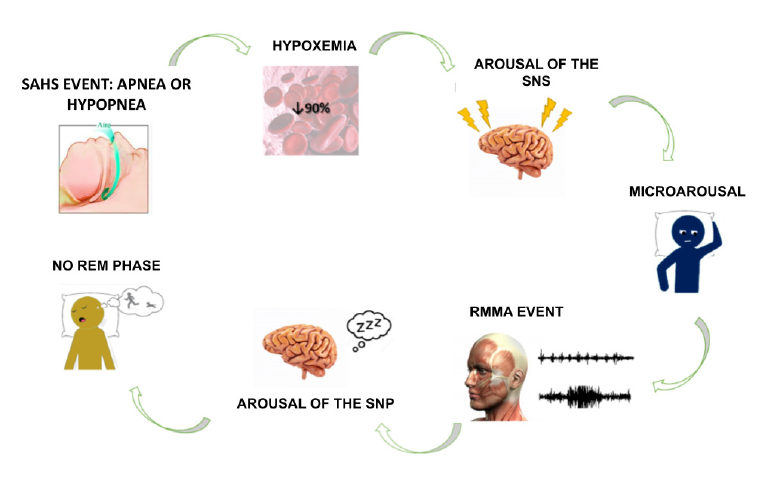
Figure 1. Diagram showing the possible mechanism linking SAHS and SB.